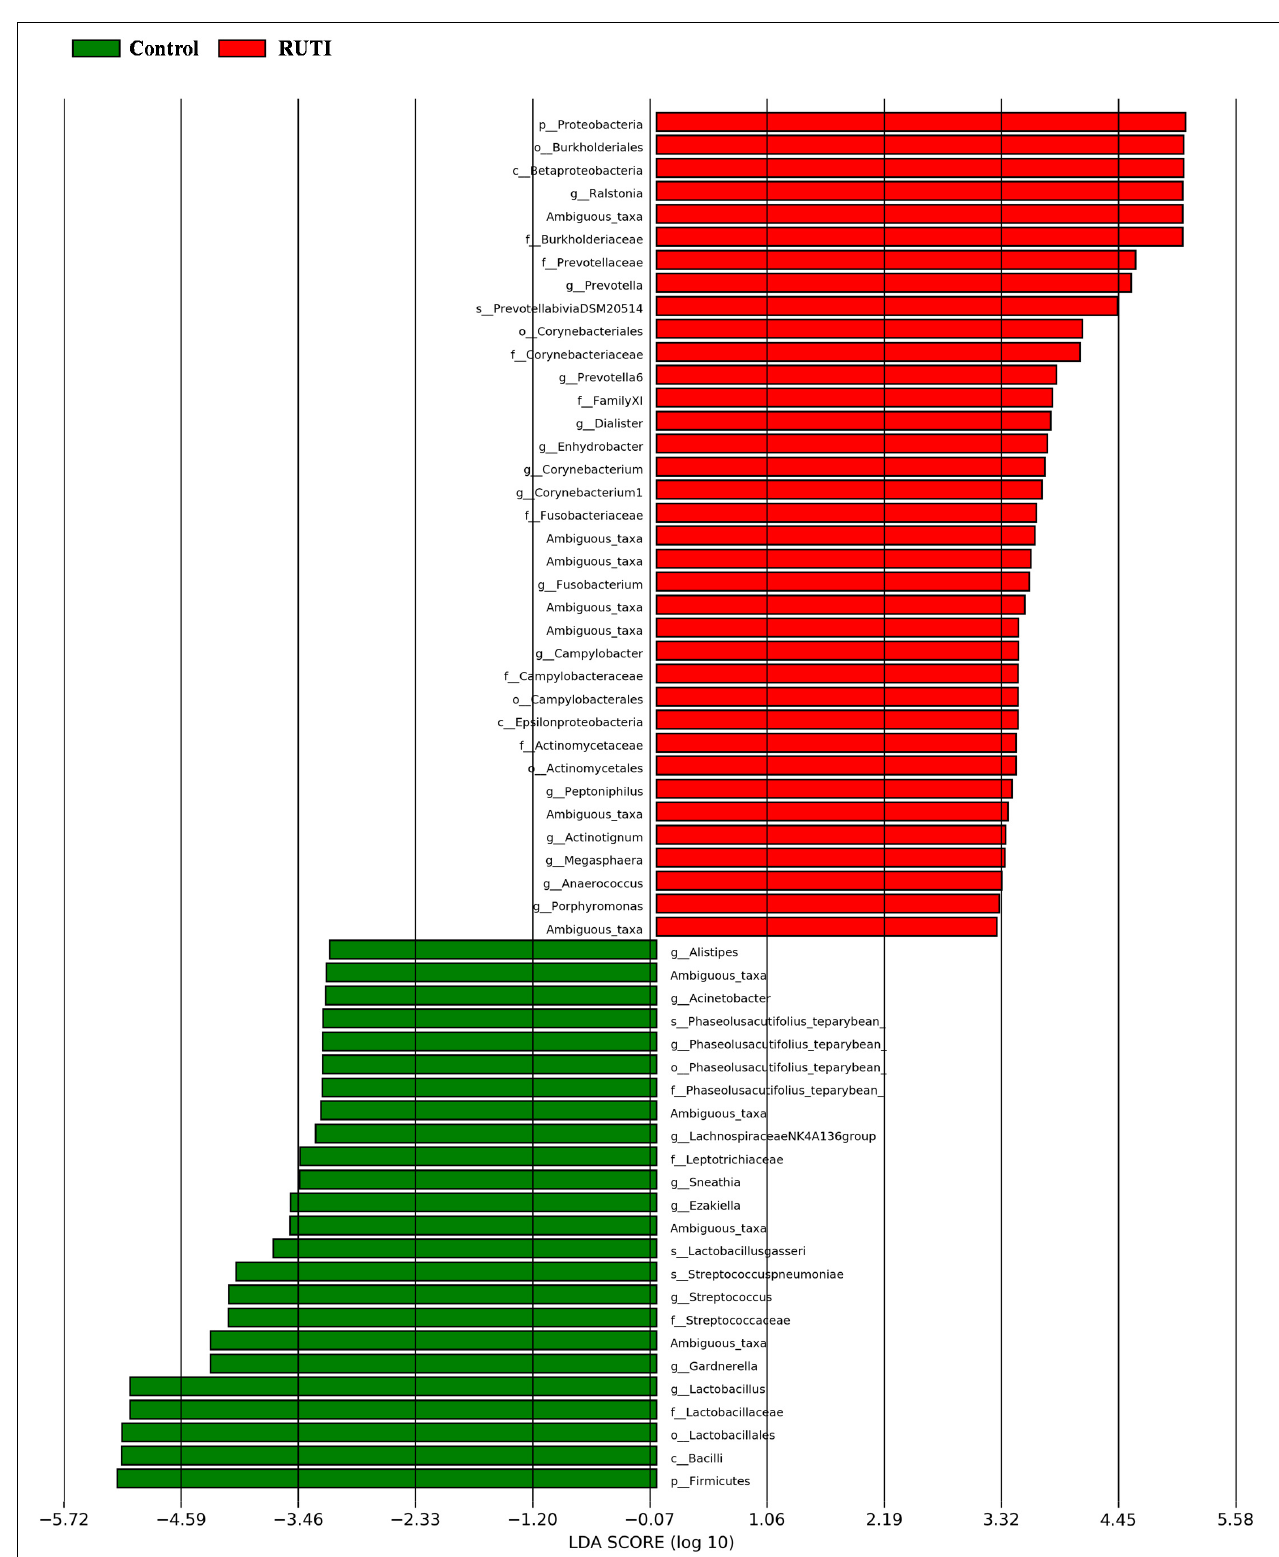
FIGURE 5 | Differentially abundant bacteria between RUTI and controls, revealed by linear discriminant analysis effect size (LEfSe) analysis, with the bacteria of P < 0.05 and LDA score > 3.